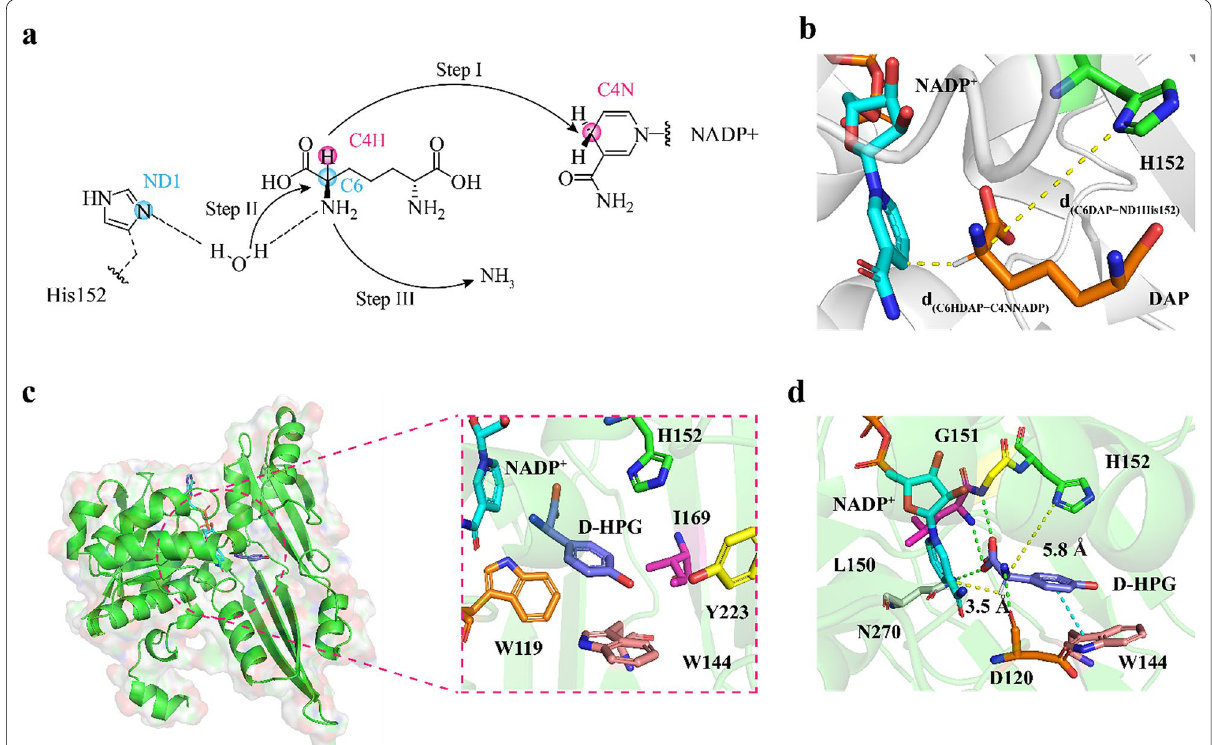
Fig. 4 Putative mechanism of DAPDH catalysis and docking analysis of Cg DAPDH BC621 -NADP + with D-HPG. a A schematic view of the DAPDH reduction mechanism adapted to DAP. The hydride transfer from DAP (C4H) to NADP + (C4N) is marked as pink spheres, the C6 of imino acid intermediate attacked by water and the ND1 of H152 are marked as blue spheres. b Two key distances in reductive amination process. The yellow dash lines denote d (C6HDAP and d (C6DAP , respectively. NADP + cofactor is shown in cyan, DAP is shown in orange, and residue H152 − C4NNADP) − ND1His152) is shown in green. c A detailed active site view of Cg DAPDH BC621 -NADP + with D-HPG. D-HPG is shown in purple, residue W119 is shown in orange, W144 is shown in light pink, I169 is shown in magenta, and Y223 is shown in yellow. d The interactions between D-HPG and Cg DAPDH BC621 and the two key distance values. The green dash lines denote hydrogen-bond interactions and the cyan dash line denote π–π stacking interaction. Residue D120 is shown in orange, L150 is shown in magenta, G151 is shown in yellow, and N270 is shown in